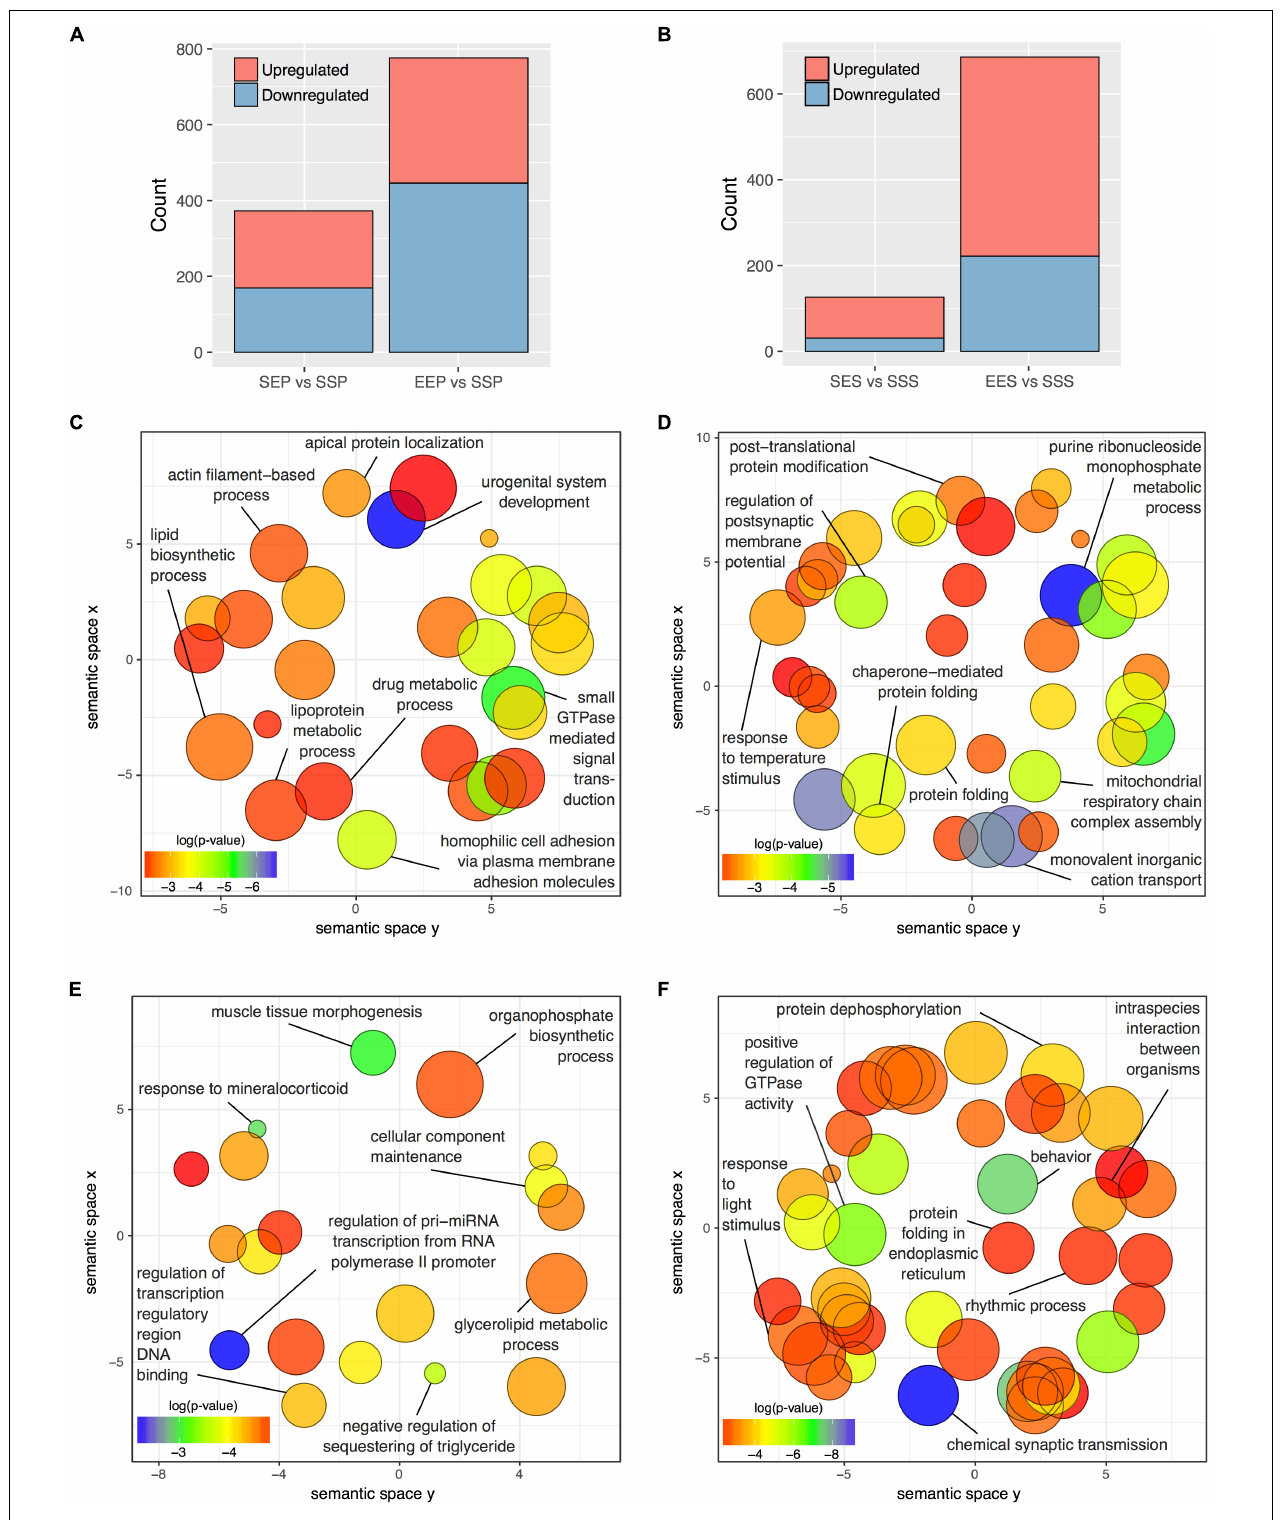
FIGURE 3 | DGE in P2 and S2 fractions following acute ethanol exposure or sensitization. The number of genes found to be significantly altered (FDR < 0.1) by sensitization and acute exposure to ethanol treatments in the (A) P2 fraction and (B) S2 fractions. Scatterplots of representative Gene Ontology Biological Process categories derived from functional enrichment analysis of genes regulated by acute ethanol (C,E) or ethanol sensitization (D,F) in the P2 fraction (C,D) and S2 fraction (E,F) . Scatterplots depict semantic similarity on axes, dispensability by size, and log 10 p -value as color.